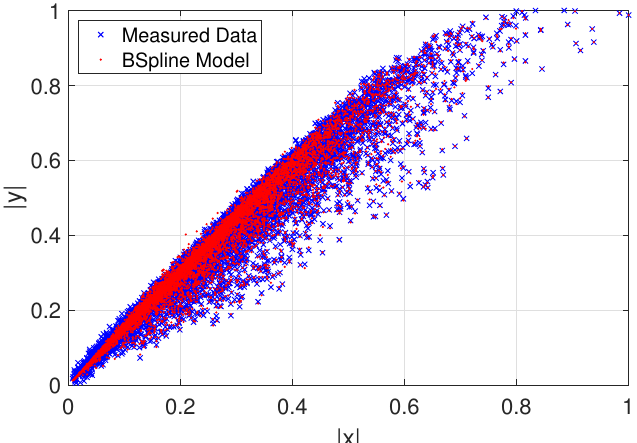
Figure 7. Approximation model with b-spline